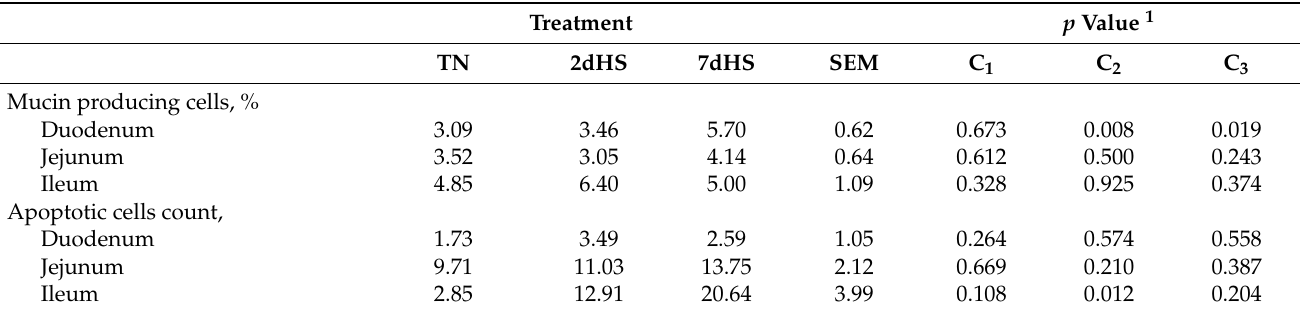
Table 7. Percentage of mucin producing cells (% of epithelial cells stained with Alcian blue/PAS) and apoptotic cell count (number of cells stained with Annexin V-FITC by 0.01 mm 2 ) in epithelium of duodenum, jejunum, and ileum of pigs exposed to thermoneutral (TN) or after 2 (2dHS) and 7 (7dHS) days of heat stress